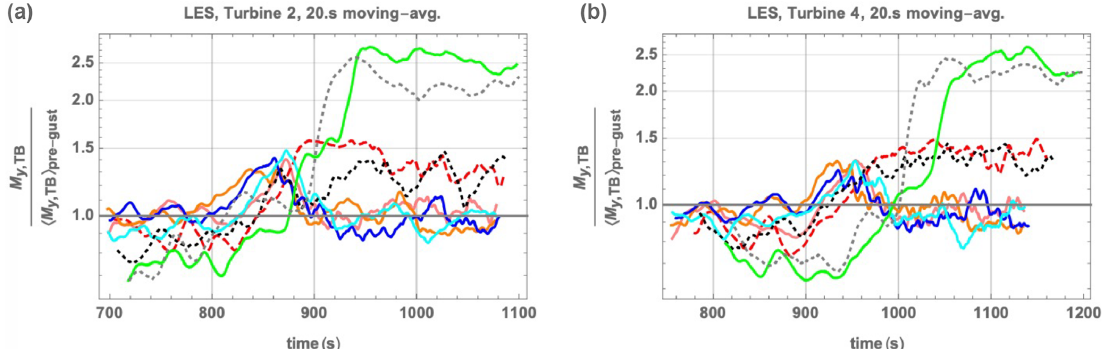
Figure 16. Tower-base fore–aft moment M tbfa normalized by pre-ramp mean values (as in Fig. 15b), for the second and fourth turbines in LES of wind farm. Color/case legend follows Figs. 11–12 and